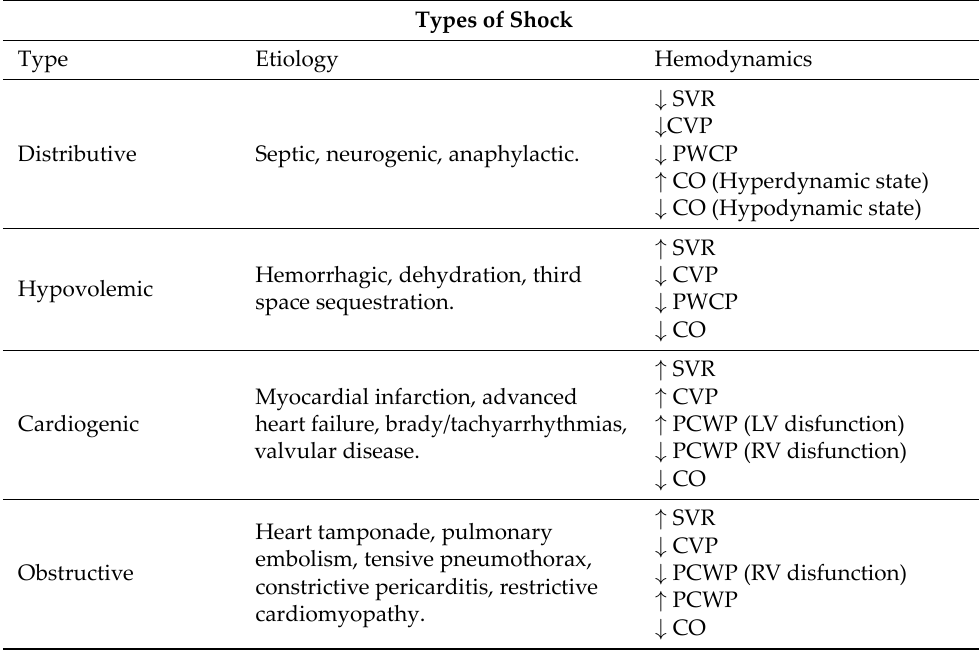
Table 1. Types of Shock [Mcgee W., Adler A., Sharma R., et al. Hemodynamic Assessment and Monitoring in the Intensive Care Unit: an Overview. Journal of Anesthesiology and Critical Care 01 Aug 2014. Doi:10.18650/2374-4448.14010]. Types of Shock Type Etiology Hemodynamics